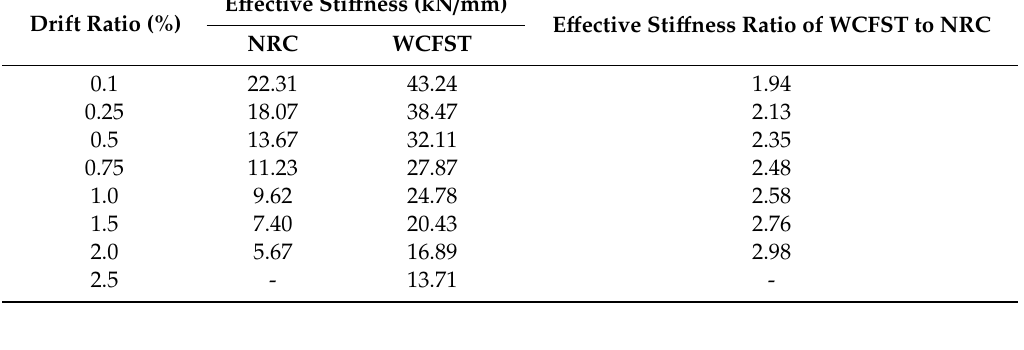
Table 4. Comparison of e ff ective sti ff ness according to the drift ratio.